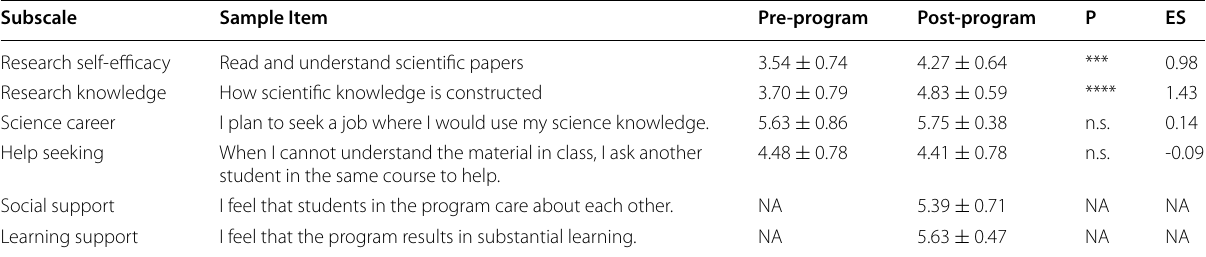
Table 2 Summary statistics for each survey subscale. Pre-program and post-program survey scores are compared for each subscale ( n 24 responses). Social support and learning support subscales were only measured in the post-program survey. Descriptive = statistics (average standard deviation), p -values, and effect size (ES, calculated as Cohen’s d) for each scale are provided. *** p < 0.001; ± **** p <.0001 n.s. Not significant Subscale